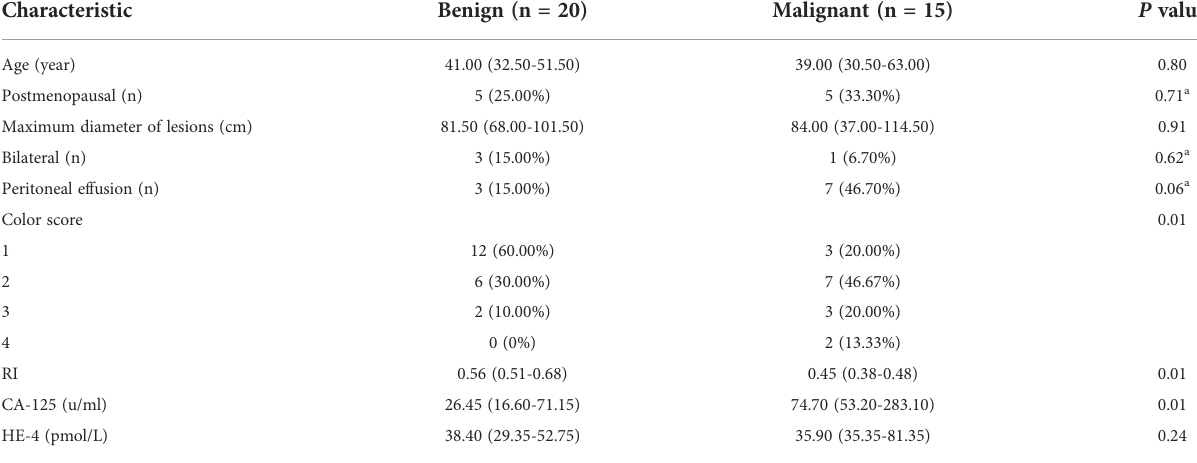
TABLE 2 Clinical and conventional sonography characteristics of patients with adnexal masses (n = 35).